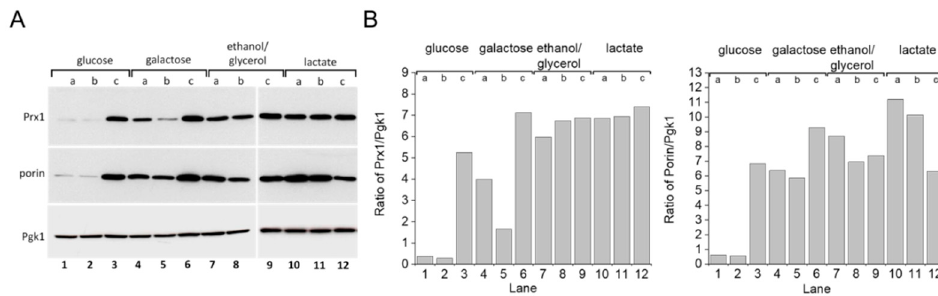
Figure 5. Mitochondrial protein expression in S. cerevisiae grown with different carbon sources and growth phases. ( A ) Immunoblotting of porin and Prx1 in yeast WT cells grown in different carbon sources. ( B ) Comparative densitometry of porin and Prx1 from panel (A). Yeast WT cells were grown in different carbon sources and collected in three different growth phases, as determined by the OD 600 . Cell extracts were prepared and proteins were separated by SDS-PAGE gel electrophoresis followed by immunoblotting with specific antibodies at the (a) early exponential (OD 600 =v1.0), (b) mid–late exponential (OD 600 = 2.0), and (c) stationary (OD 600 > 2.0) growth phases. Pgk1 protein was used as the gel loading control. All experiments were performed in triplicate and repeated at least